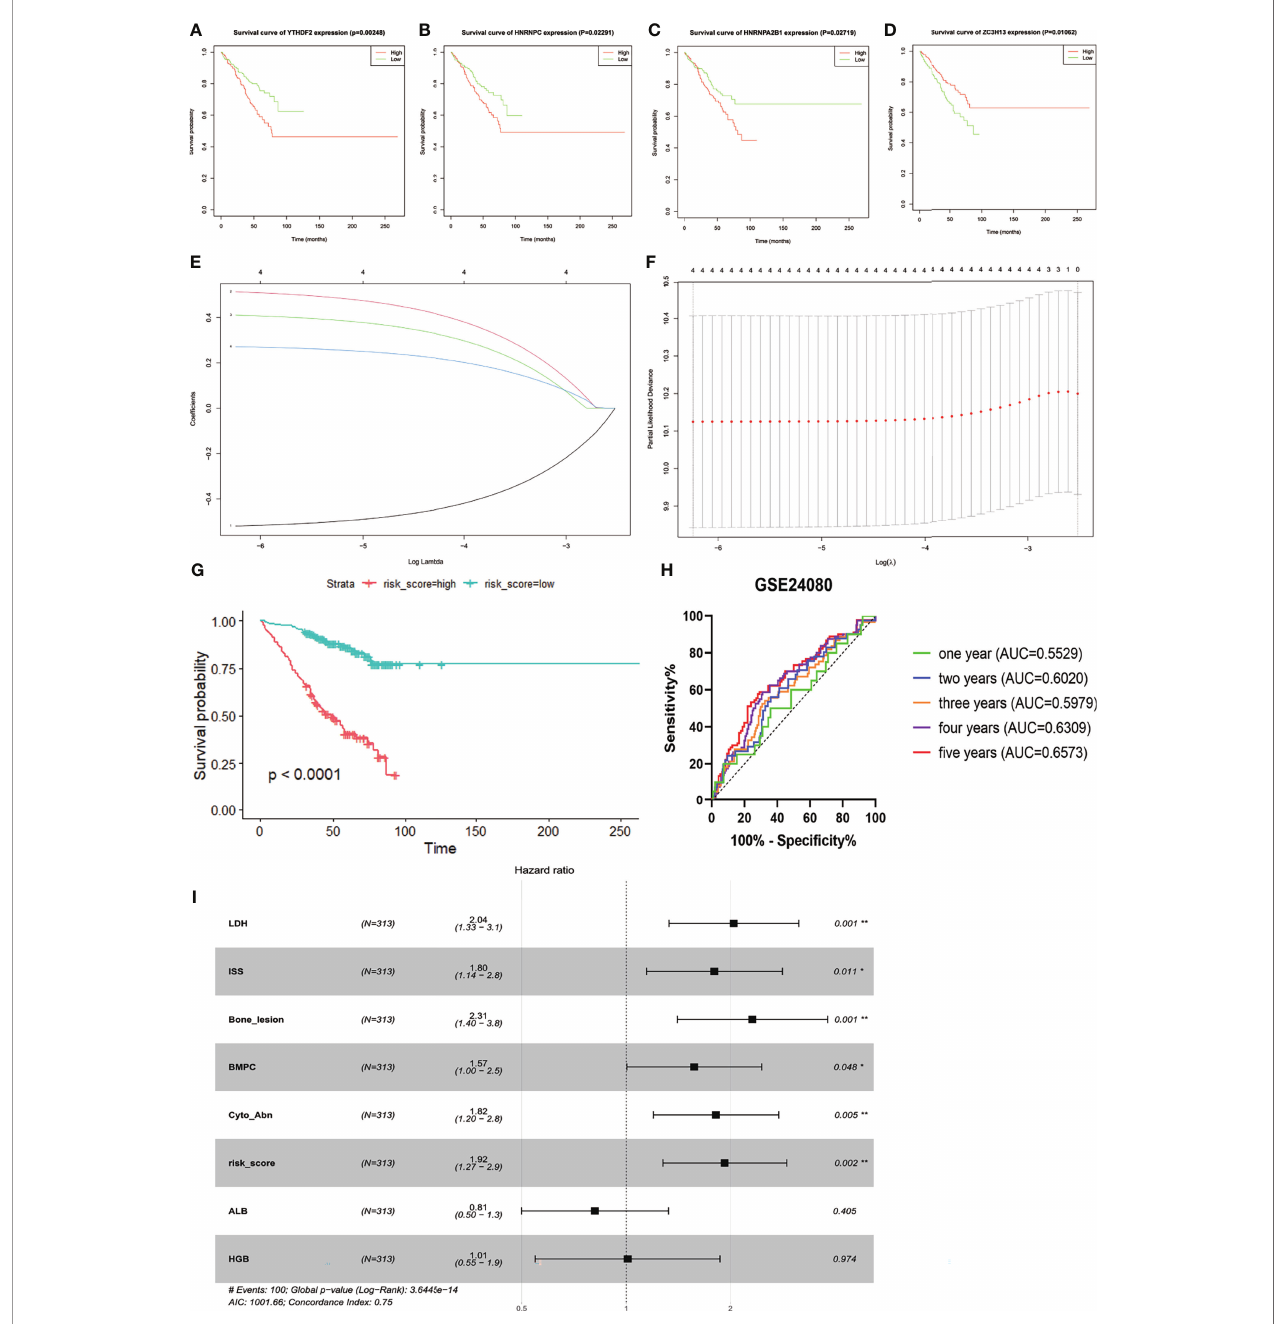
FIGURE 2 | Construction and evaluation of the four-gene prognostic risk signature in the training cohort of MM patients. Kaplan – Meier survival curves for YTHDF2 (A) , HNRNPC (B) , HNRNPA2B1 (C) , and ZC3H13 (D) . (E) The LASSO Cox analysis identi fi ed four m6A-related genes in the training cohort. Each curve corresponds to one gene (red, HNRNPA2B1; green, HNRNPC; blue, YTHDF2; black, ZC3H13). (F) Partial likelihood deviance of different numbers of variables. One-thousand-fold cross-validation was applied for tuning penalty parameter selection. (G) Kaplan – Meier survival analysis by different risk score levels in training cohort. (H) ROC curve was applied to assess the predictive ef fi ciency of the prognostic risk signature. (I) Forest plot of the multivariate Cox regression analysis. *P<0.05,